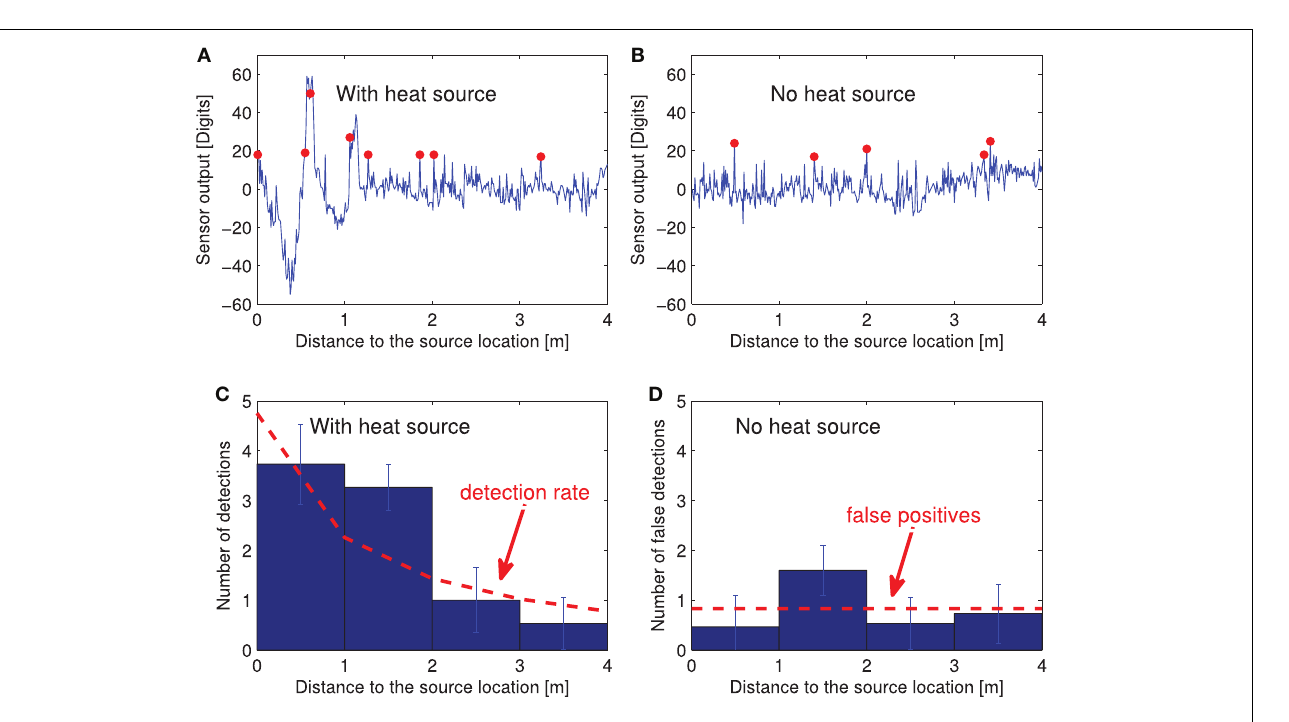
variation in temperature exceeds 15 digits. (C,D) Histogram of the number of detections with respect to the source distance d with and without the heat source ( n = 12 trials in each condition). The dashed curve in C corresponds to a fit with the detection rate R ( ⃗ r , ⃗ r 0 ) derived in the Section “Appendix” with a correlation length of λ = 20au. The dashed line in D corresponds to a mean false alarm rate of 0.08detection/s.